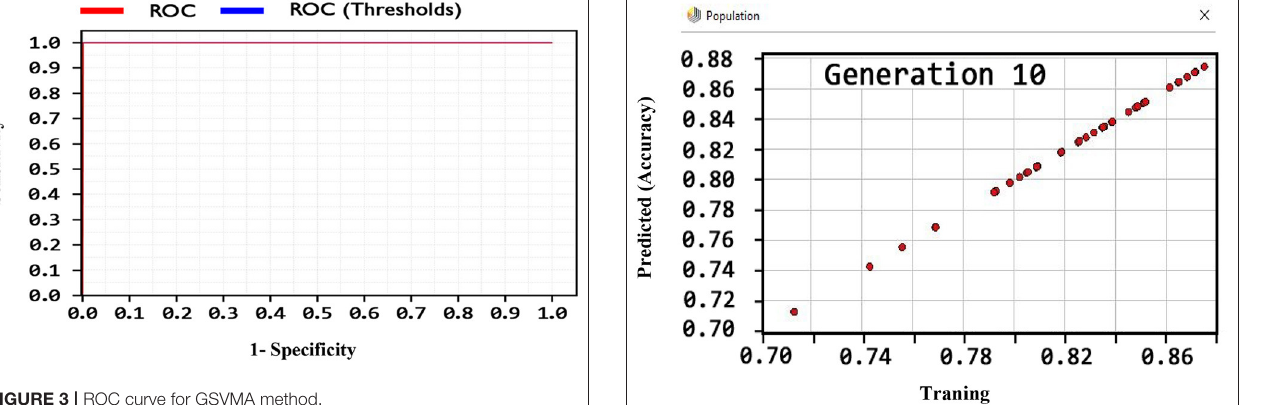
FIGURE 3 | ROC curve for GSVMA method.